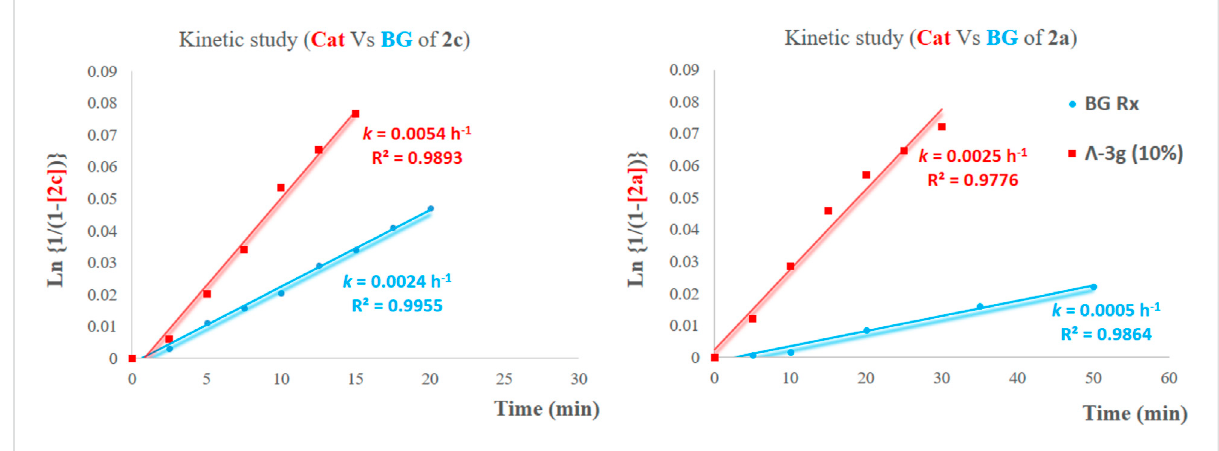
FIGURE 2 Kinetic studies on the iodocyclization reaction of enol